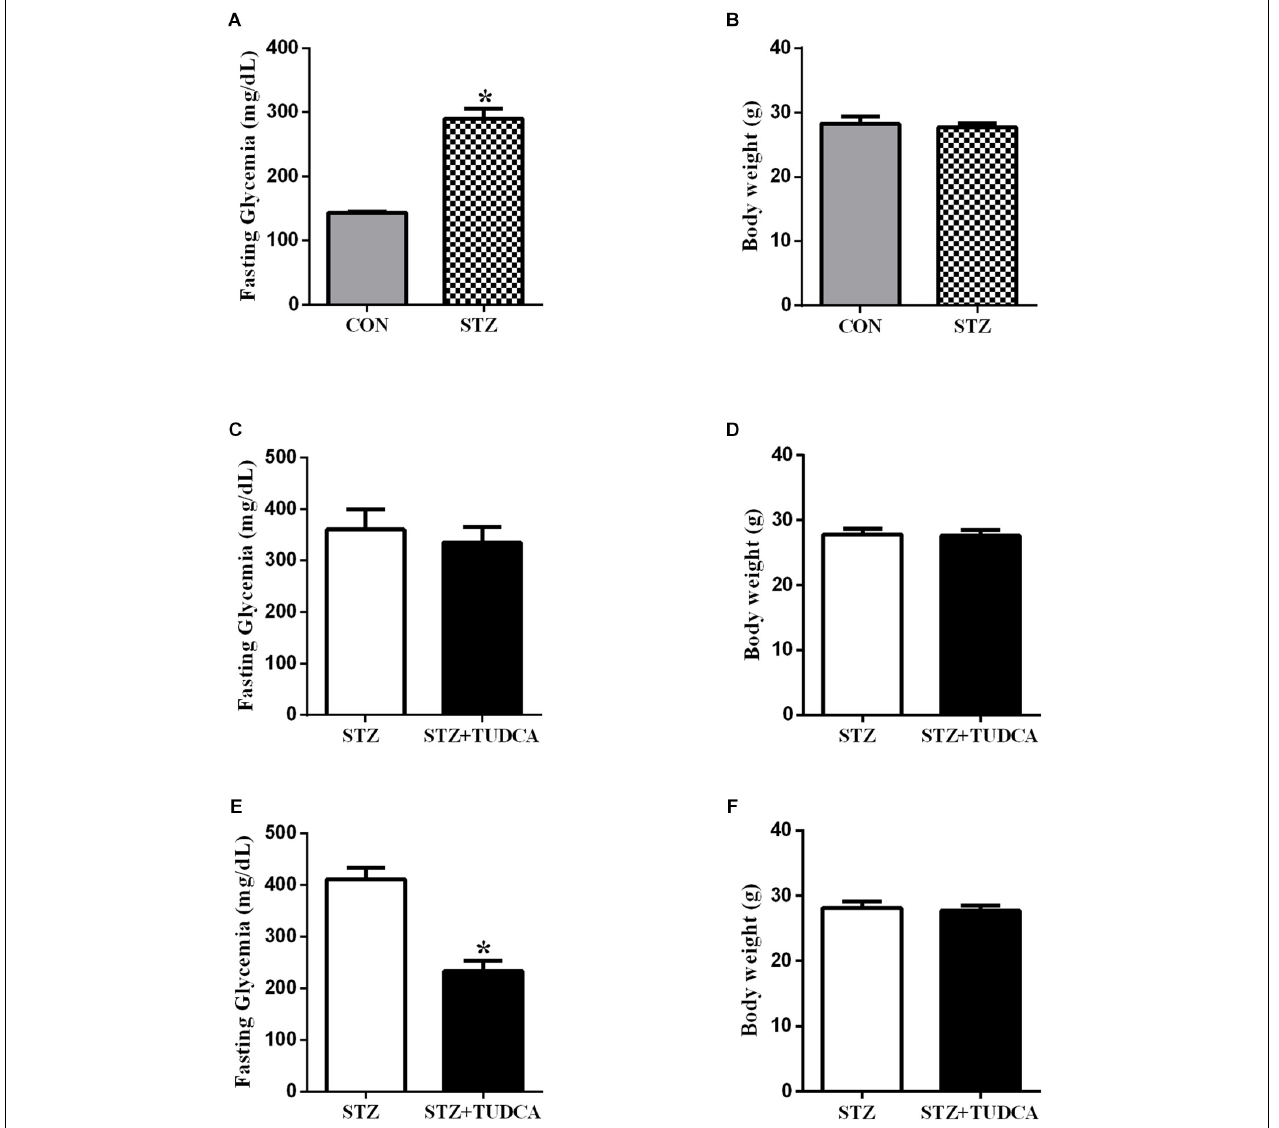
FIGURE 2 | TUDCA treatment improves fasting glycemia from early-stage T1D mice. Fasting glycemia of CON (gray bar, n = 6) and STZ (grid bar, n = 21) (A) . Body weight of CON (gray bar, n = 6) and STZ (grid bar, n = 21) (B) at the end of the streptozotocin administration. Fasting glycemia of STZ (white bar, n = 10) and STZ + 7 days of TUDCA treatment (black bar, n = 11) (C) . Body weight of STZ (white bar, n = 10) and STZ + 7 days of TUDCA treatment (black bar, n = 11) (D) . Fasting glycemia of STZ (white bar, n = 10) and STZ + 15 days of TUDCA treatment (black bar, n = 11) (E) . Body weight of STZ (white bar, n = 10) and STZ + 15 days of TUDCA treatment (black bar, n = 11) (F) . Data are the mean ± SEM. ∗ P ≤ 0.05 (Student’s t -test or Mann-Whitney test).